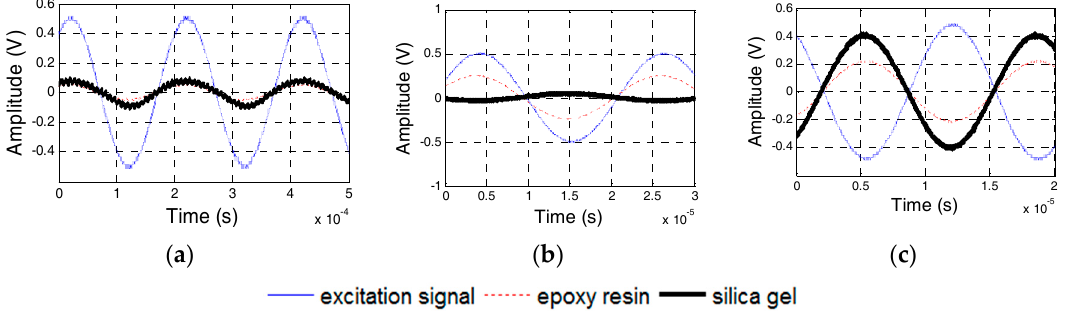
Figure 21. PZT transducer signals of Specimens 4. ( a ) 4 kHz Excitation Frequency; ( b ) 30 kHz Excitation Frequency; and, ( c ) 55 kHz Excitation Frequency.